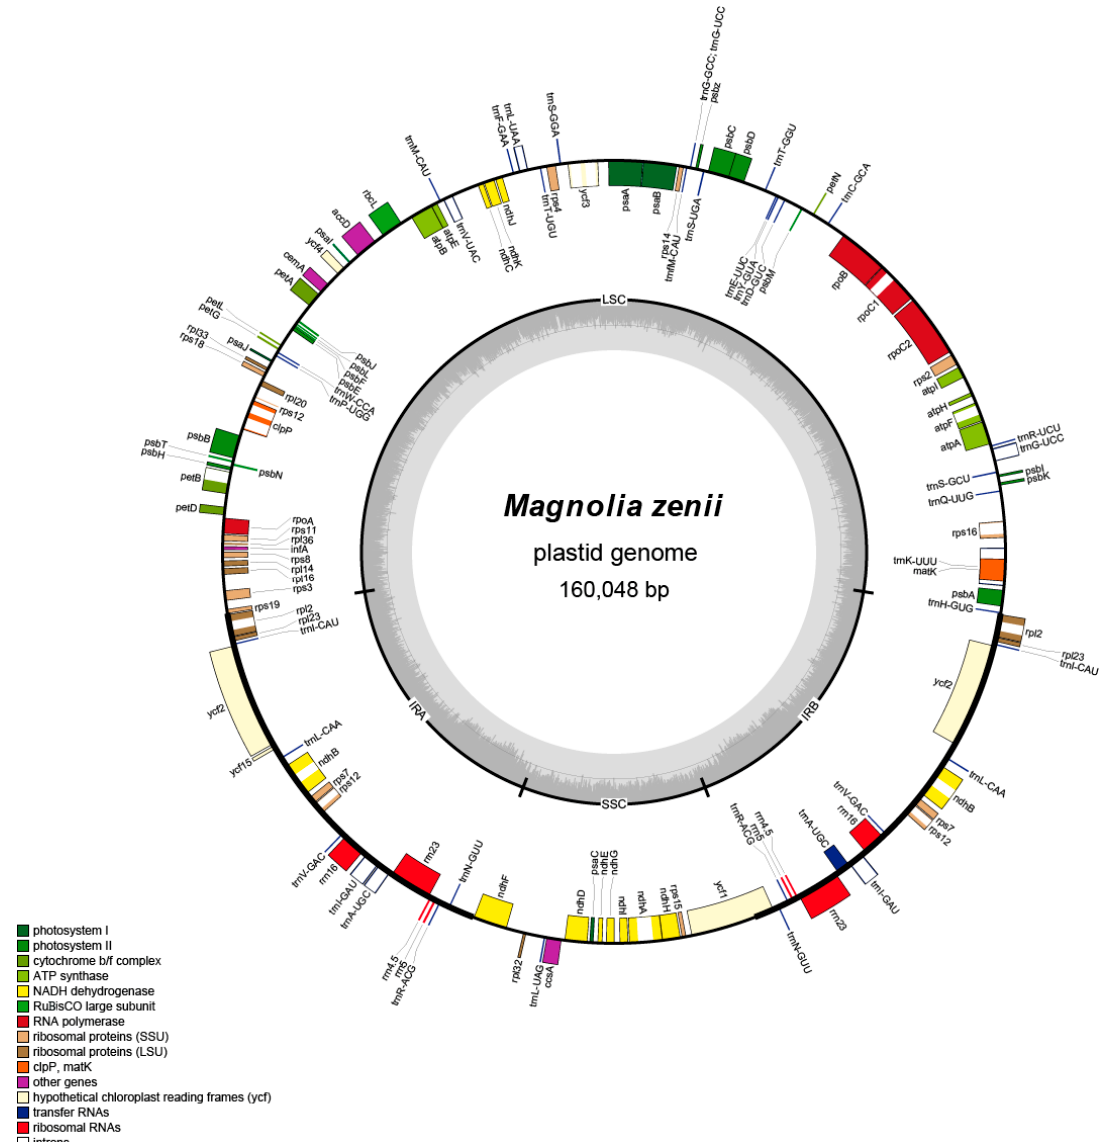
Figure 1. Plastid genome map of M. zenii . Genes inside the circle are transcribed clockwise, and those outside are transcribed counterclockwise. Genes of different functions are color-coded. The darker gray in the inner circle shows the GC content, while the lighter gray shows the AT content.